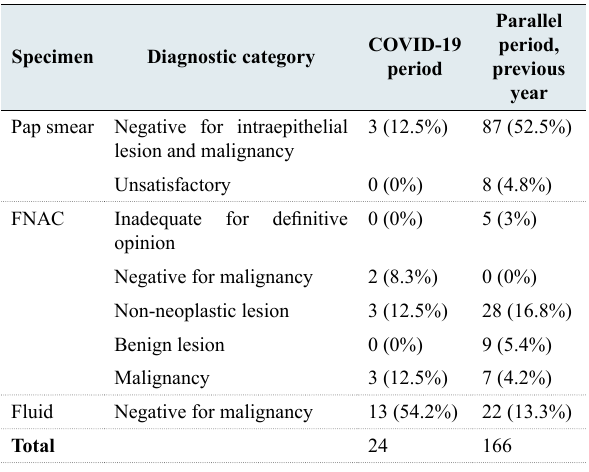
Table 1: Distribution of the diagnostic category of cytology